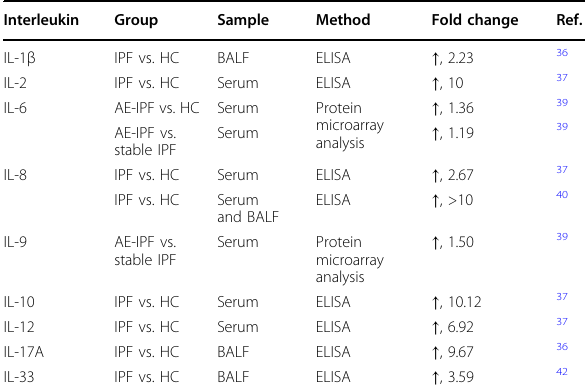
Table 1 Changes of interleukin levels in patients with pulmonary fi